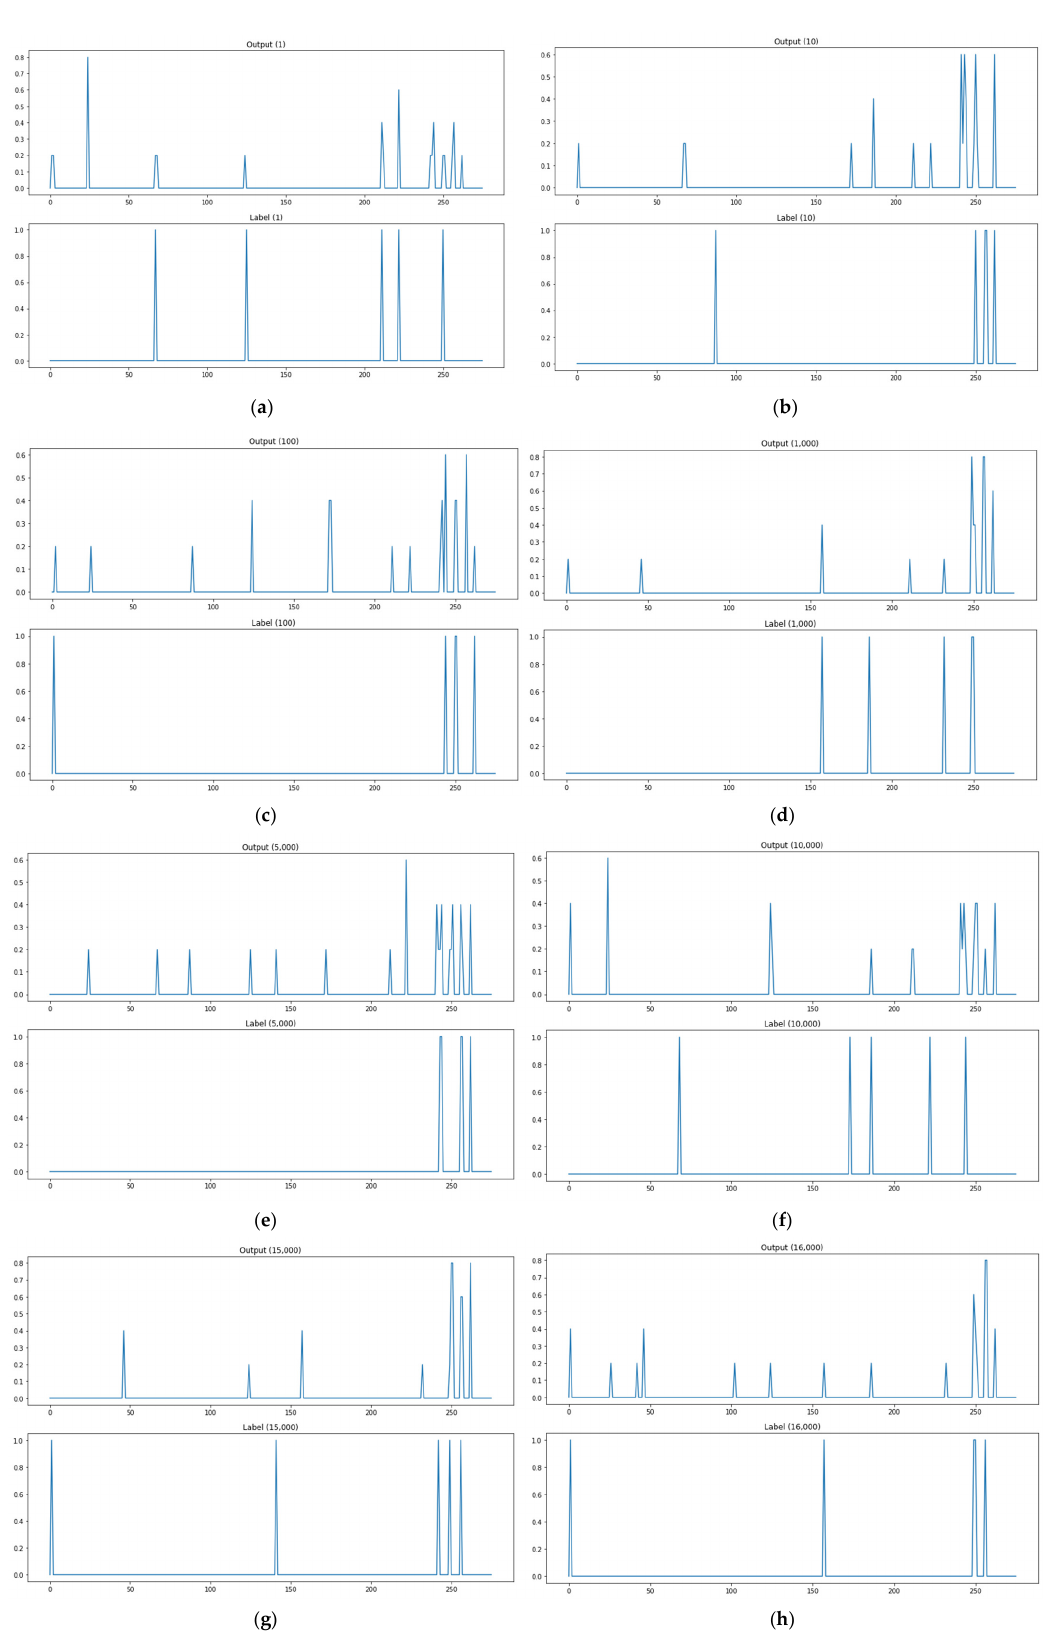
Figure 10. The prediction results of the algorithm adaptation method based on kNN classification. ( a ) Test data 1. ( b ) Test data 10. ( c ) Path test data 100. ( d ) Path test data 1,000. ( e ) Path test data